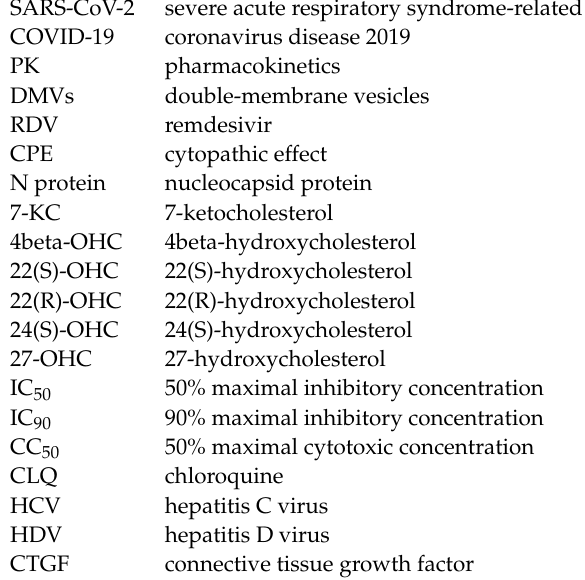
Figure S1: Chemical structure of the natural oxysterols used in this study, Figure S2a: Proton spec- trum of Oxy133, Figure S2b: Carbon spectrum of Oxy133, Figure S3a: Proton spectrum of Oxy186, Figure S3b: Carbon spectrum of Oxy186, Figure S4a: Proton spectrum of Oxy210, Figure S4b: Carbon spectrum of Oxy210, Figure S5a: Proton spectrum of Oxy232, Figure S5b: Carbon spectrum of